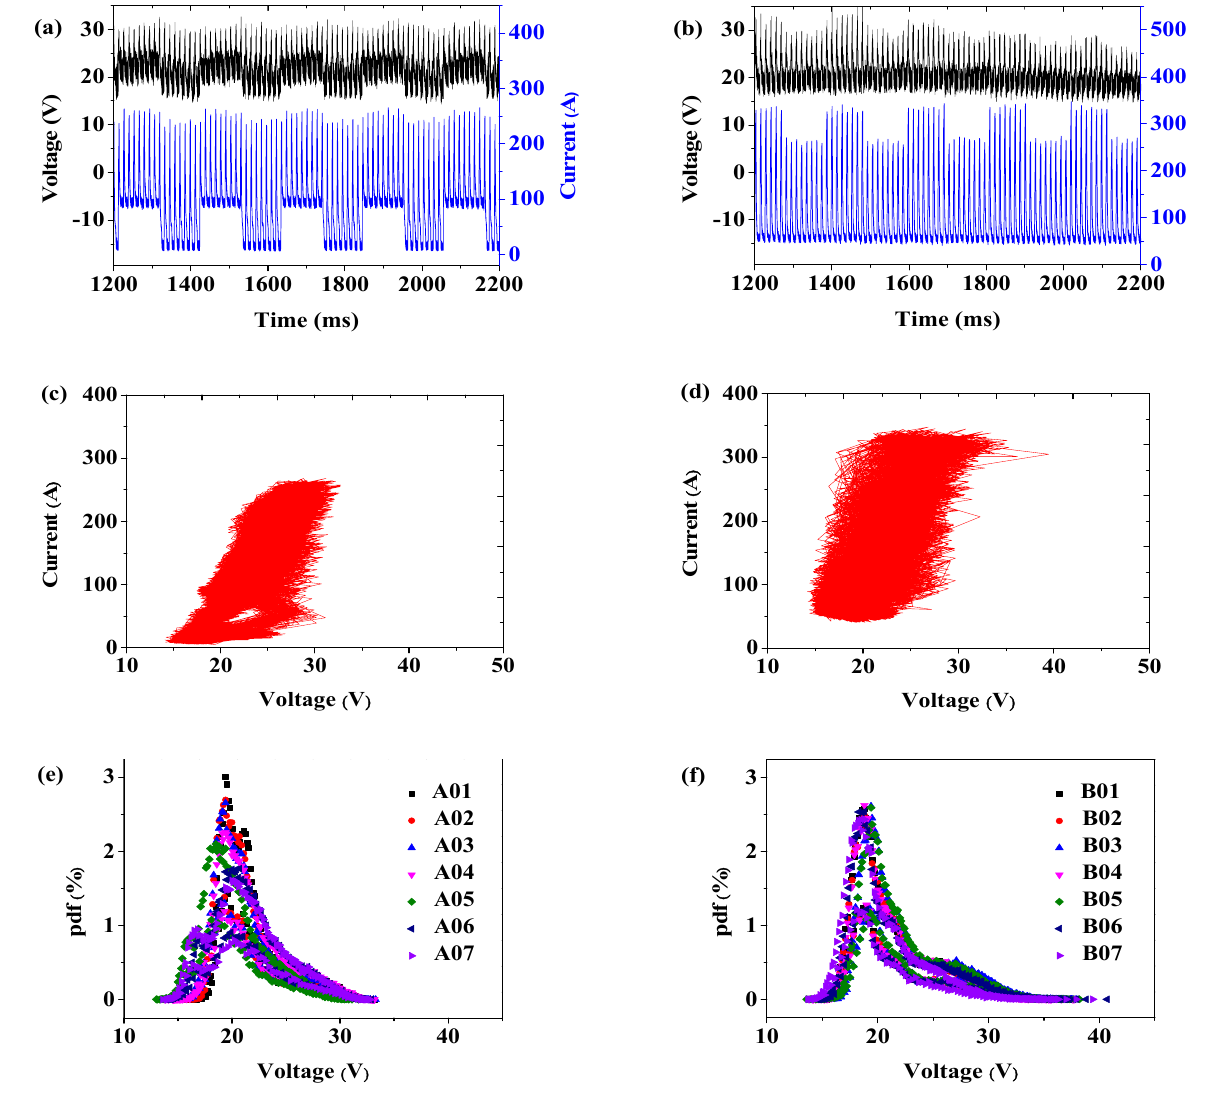
Figure 5. The analysis results of electrical signals: ( a ) voltage–current waveform of specimen A07; ( b ) voltage–current waveform of specimen B07; ( c ) the electrical signal statistics of specimen A07; ( d ) the electrical signal statistics of specimen B07; ( e ) welding voltage PDF results of specimens A01–A07; ( f ) welding voltage PDF results of specimens B01–A07.